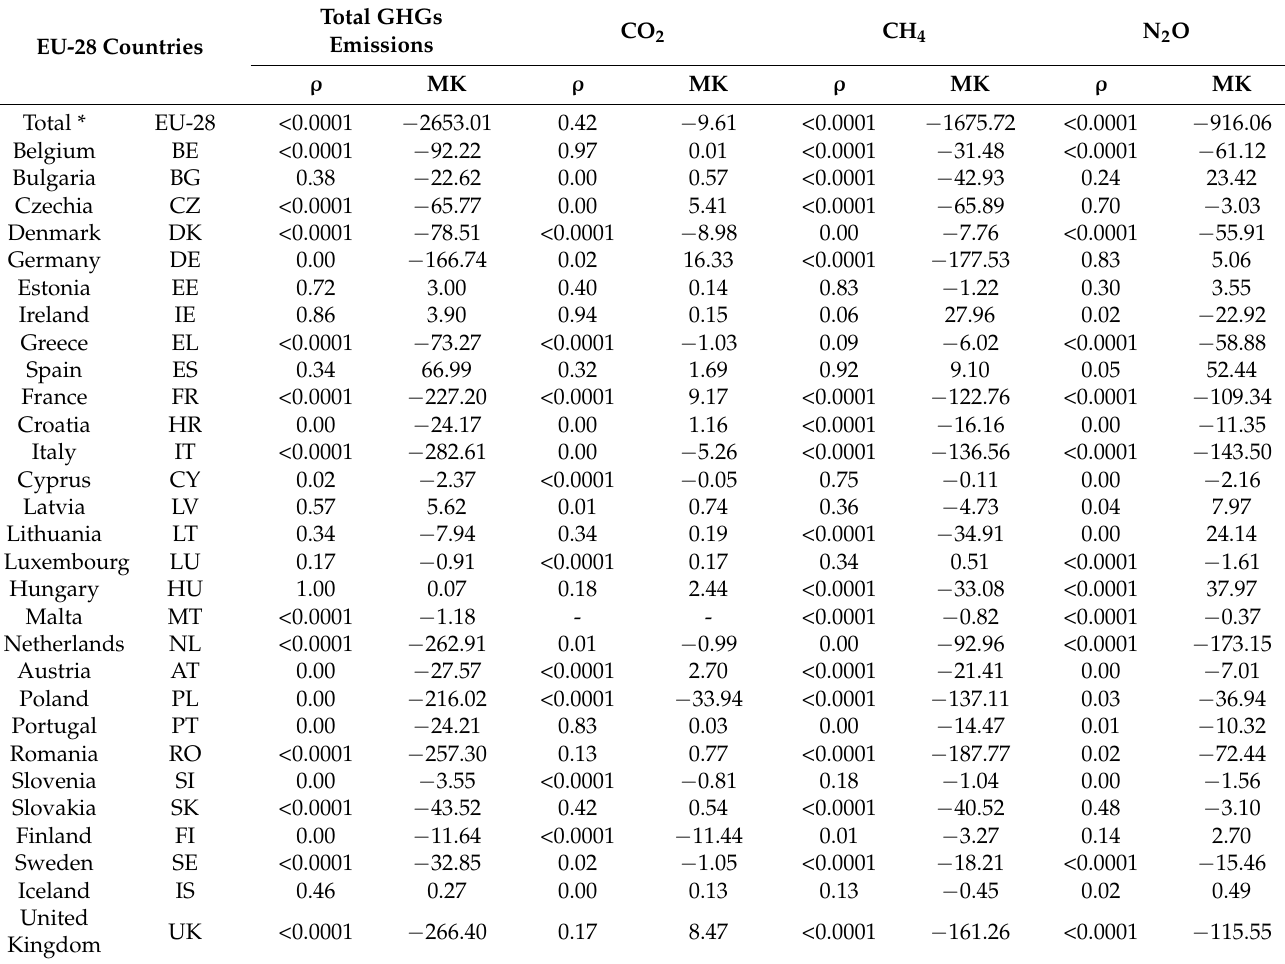
Table 2. Trend analysis of GHG emissions and its component across EU-28 countries between 1990 and